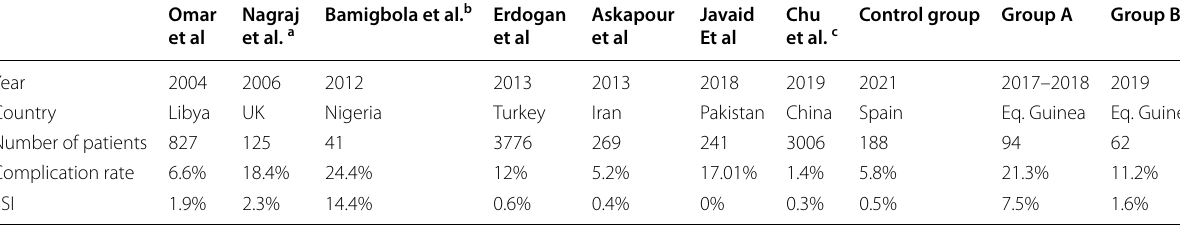
Table 3 Complication rates reported in different studies and rates found in this